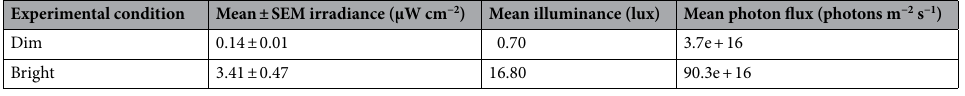
Table 1. Photometric characteristics of the green light